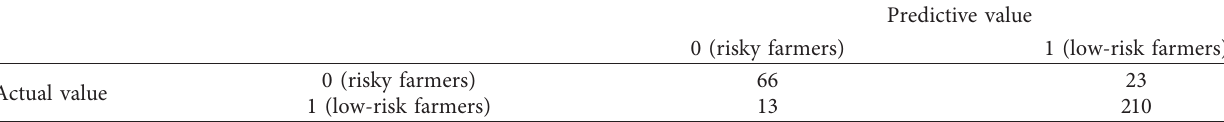
Table 8: Confusion matrix results of the XGBoost model after tuning.